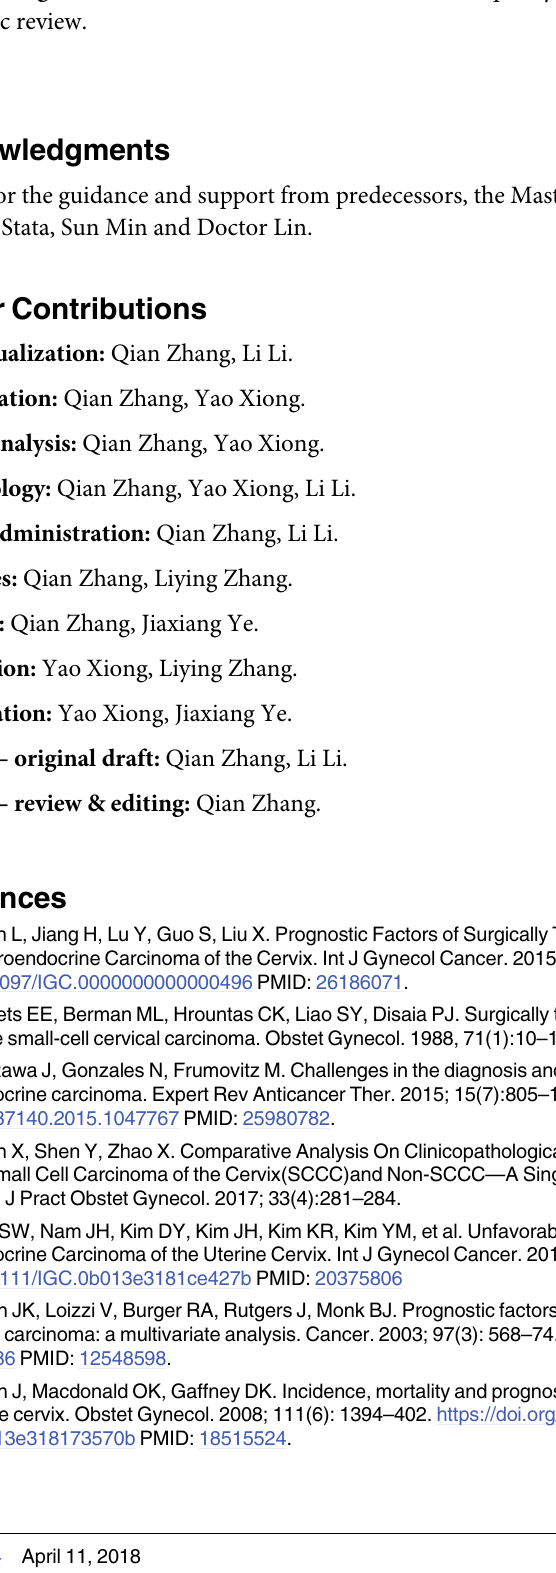
S1 Flow Diagram. PRISMA 2009 flow diagram. A PRISMA 2009 flow diagram for this sys- tematic